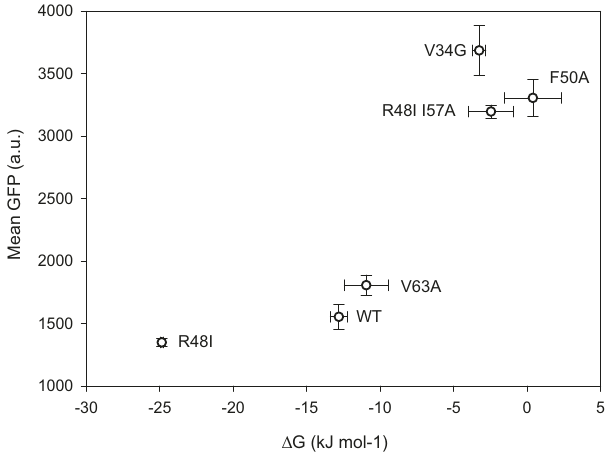
Fig. 4 Correlation between GFP fl uorescence and protein stability. Six CI2 variants were co-expressed with the protein folding sensor (pSEVA631(Sp)-lbpAp-GFP-ASV), and the GFP fl uorescence was analyzed by FACS. The average mean GFP fl uorescence was compared to the Gibbs free energy of unfolding ( Δ G unf ) determined from global fi ts of thermal and chemical unfolding of each protein. All measurements were determined in triplicates and the data are presented as mean values± standard deviation. Source data are provided as a Source Data fi